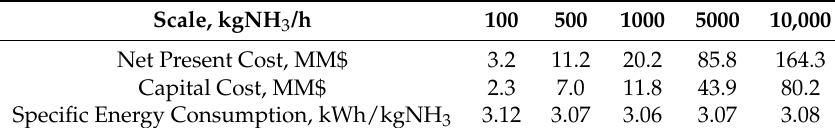
Table 9. Absorbent-enhanced ammonia synthesis optimal design results.